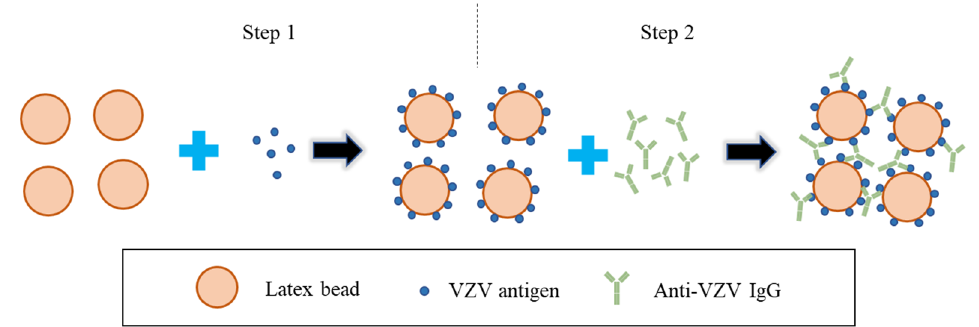
Figure 6. Schematic diagram depicting the basic steps of LA for the detection of anti-VZV antibodies. (1) The latex beads are coated with VZV antigen (e.g., purified VZV gE). (2) Serially diluted serum samples are added to the synthetic latex beads coated with VZV antigen, and the test samples are determined as positive by the observation of the agglutination reaction.